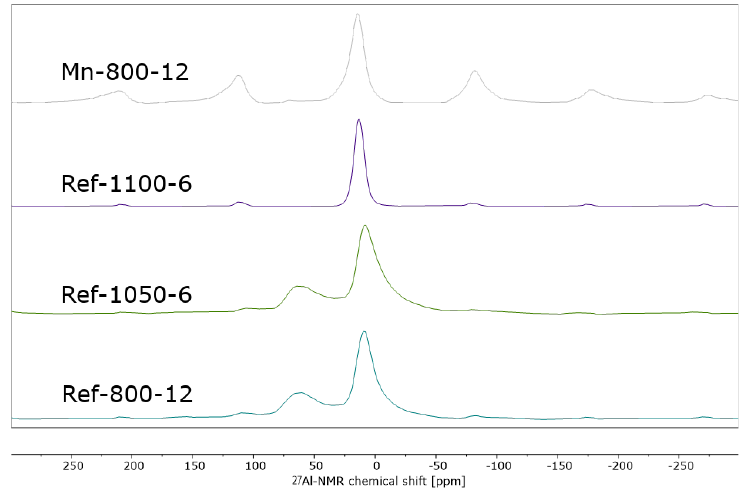
Figure 4. 27 Al - MAS - NMR spectrum of sample Mn - 800 - 12, calcined at 800 °C for 12 h after acid Figure 4. 27 Al-MAS-NMR spectrum of sample Mn-800-12, calcined at 800 ◦ C for 12 h after acid treatment to remove Mn - species. For comparison, spectra of Mn - free reference samples are given , treatment to remove Mn-species. For comparison, spectra of Mn-free reference samples are given, which were calcined at 800 °C for 12 h, 1050 °C for 6 h and 1100 °C for 6 h. which were calcined at 800 ◦ C for 12 h, 1050 ◦ C for 6 h and 1100 ◦ C for 6 h.